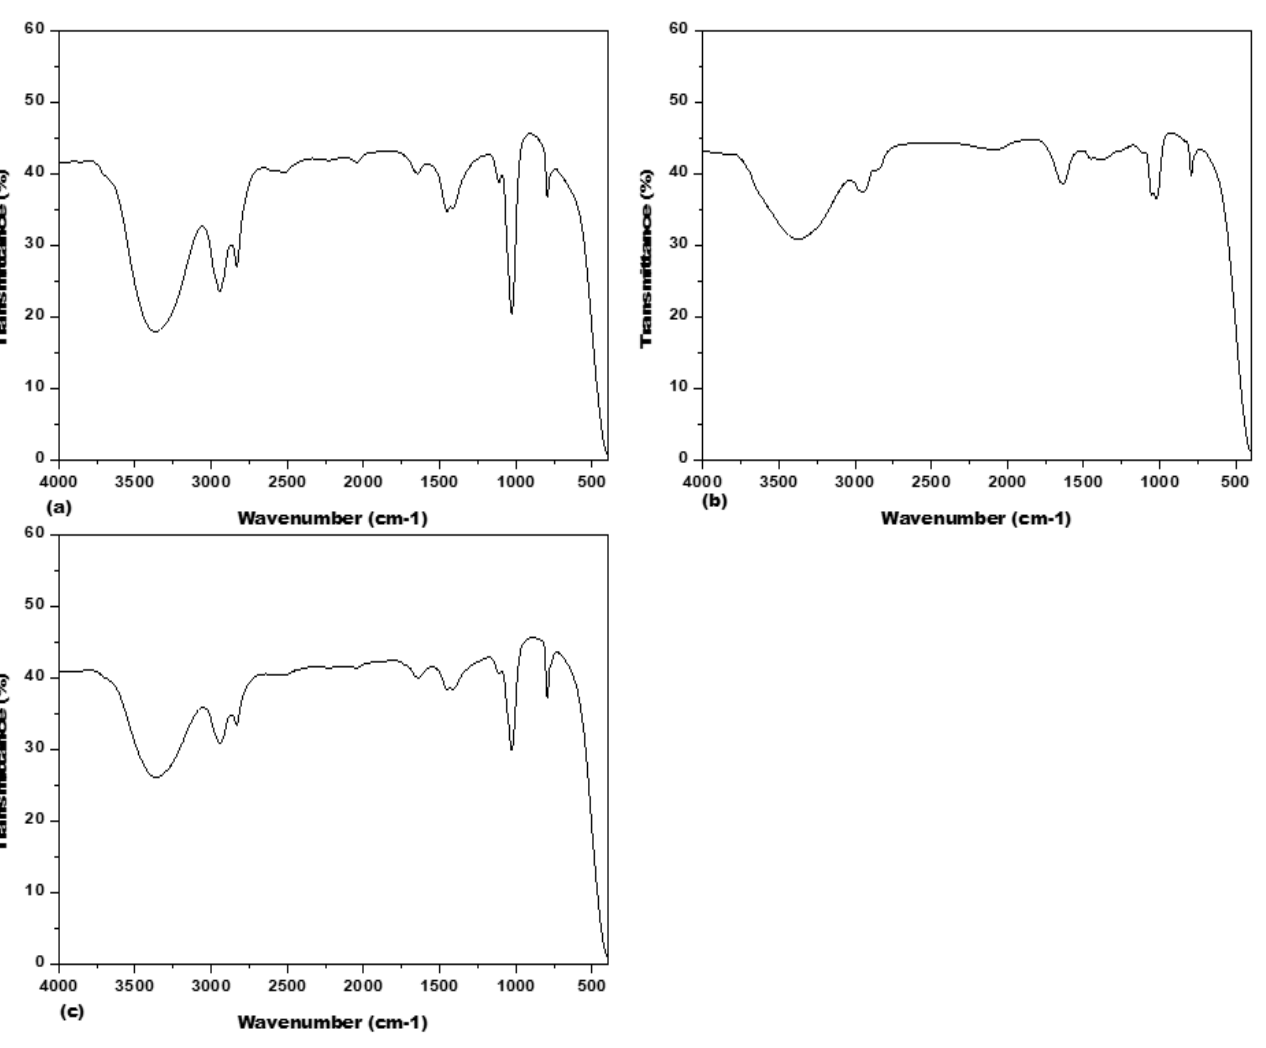
Figure 9. Fourier Transform Infrared Spectroscopy (FTIR) analysis for the methanolic extract of Acacia species : ( a ) A. johnwoodii ; ( b ) A. etbaica ; ( c ) A. origena . Table 3. Fourier Transform Infrared Spectrometer (FTIR) spectrum analysis for the methanolic extract of A. origena